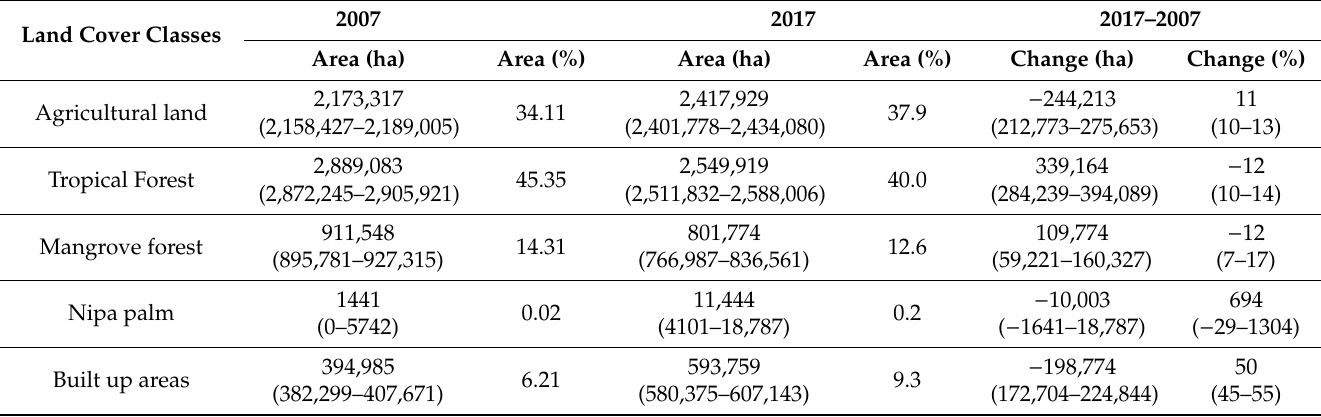
Table 6. Change Detection analysis Using SVM–RBF kernel for each Land cover between 2007 and 2017 over the Study Area. Land cover class areas reported with 95% confidence interval in